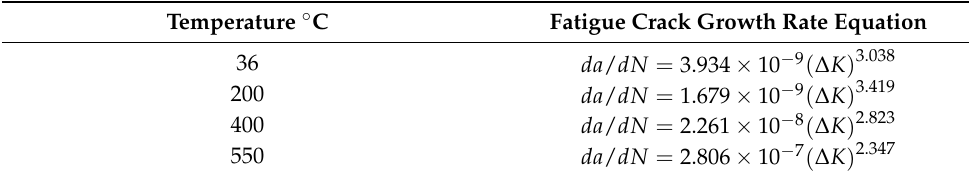
Table 5. The test results of the fatigue crack